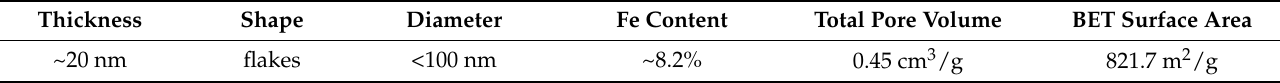
Table 1. Main features of